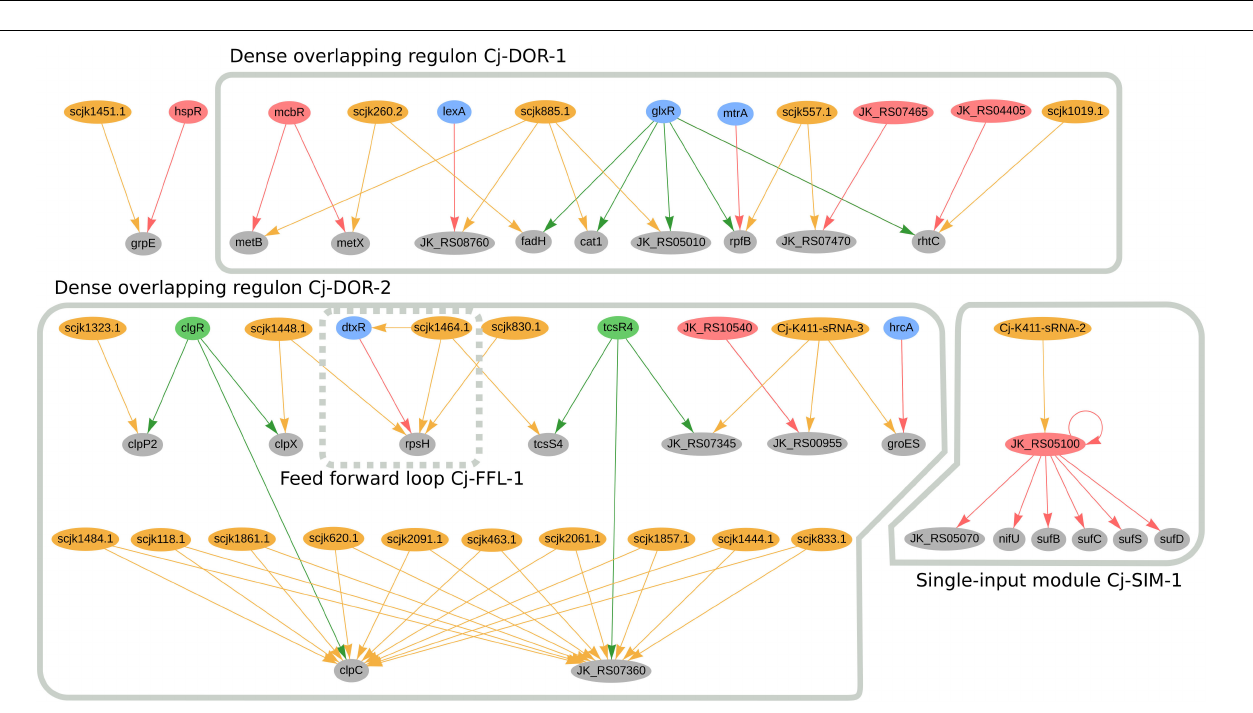
FIGURE 6 | Genes regulated by sRNAs and regulatory proteins in C. jeikeium K411. In the network, green nodes represent activator proteins, red nodes represent repressor proteins, blue nodes represent dual regulators (i.e., that can activate and repress gene expression), orange nodes represent sRNAs and gray nodes represent target genes. The arrows represent the regulatory interactions and their colors represent the same roles as the ones in the nodes.